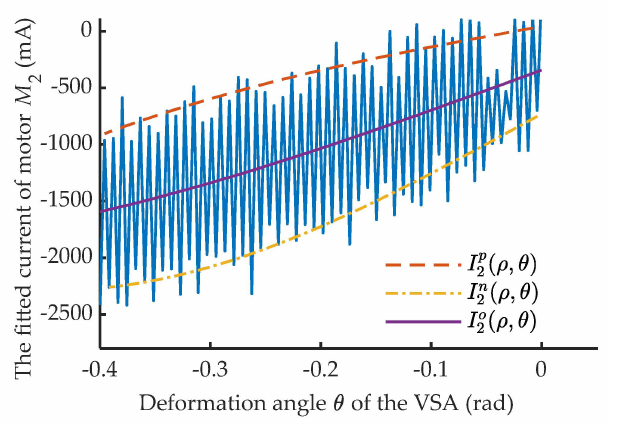
Figure 16. Current estimation for cam C 2 ( AB > OA , ρ = 0.048